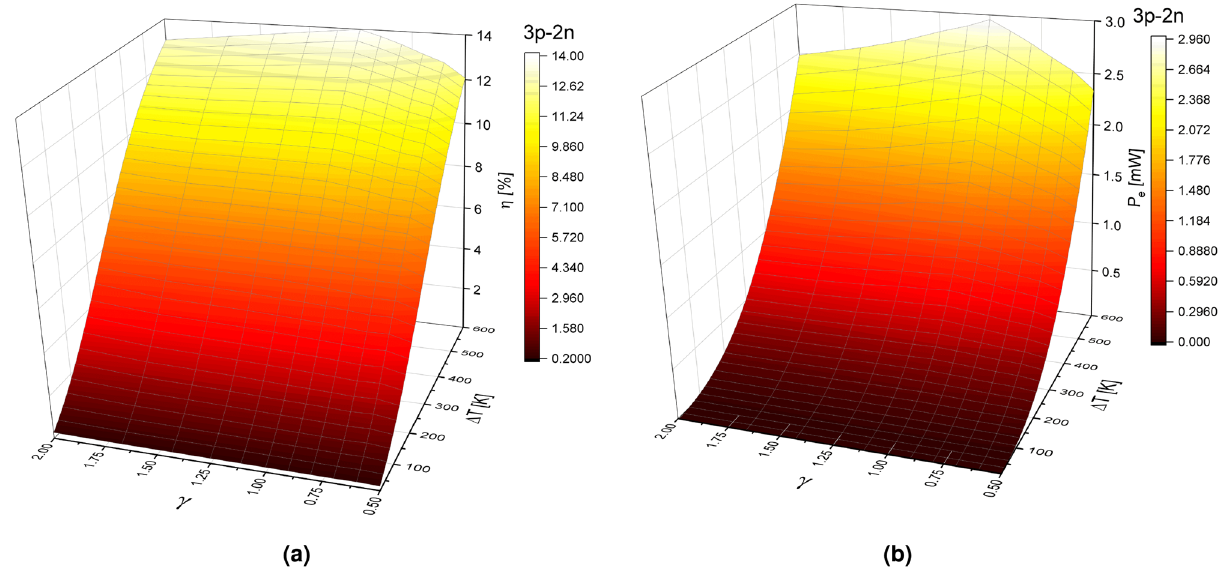
Figure 4. ( a ) Efficiency (η) and ( b ) Output power ( P e ) in function of geometric factor (γ) and temperature difference (� T ) for a TEG in the 3p-2n model at R L = 5.83 (cid:31) .